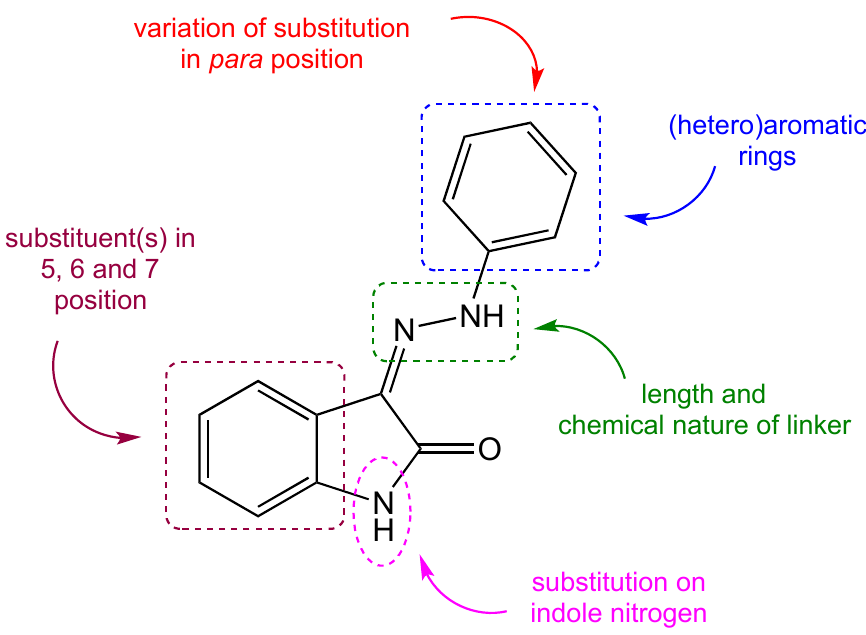
Figure 2. Summary of the investigated structural modifications of